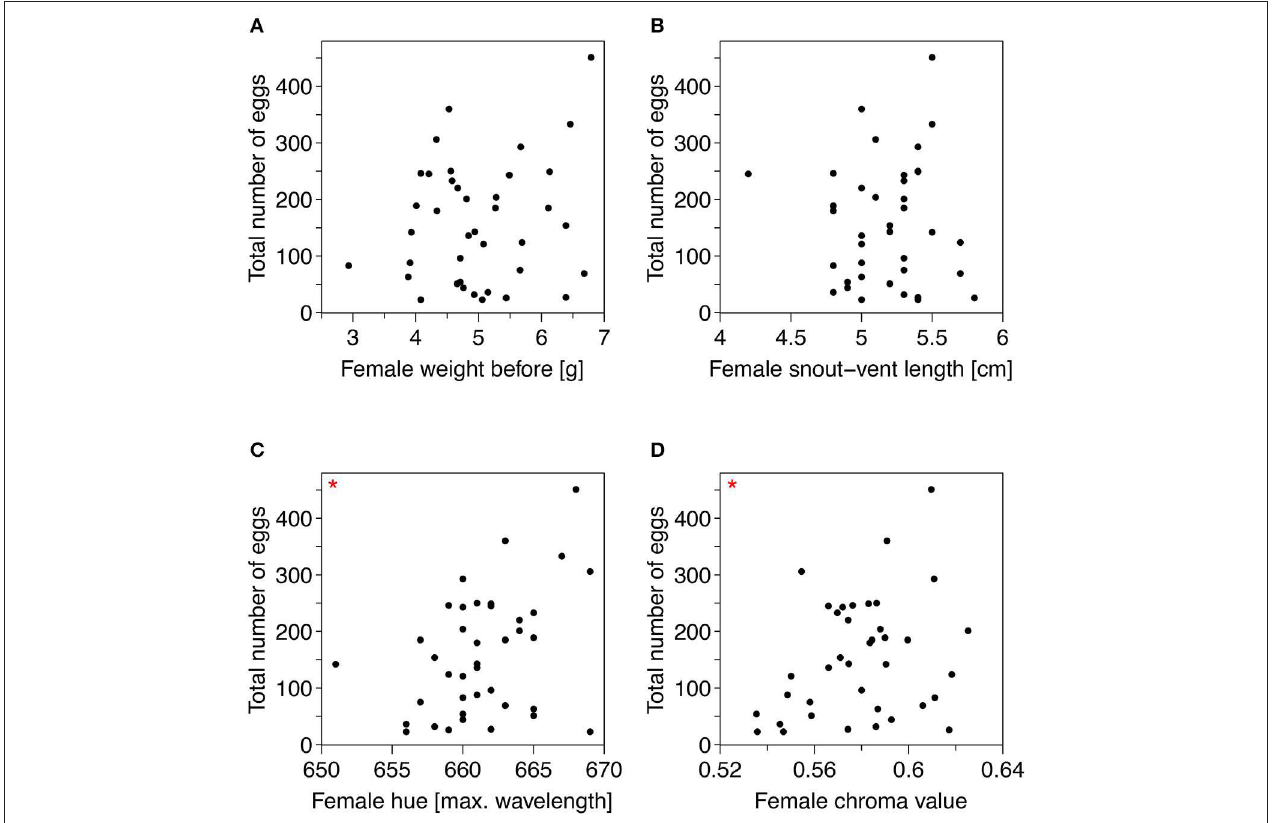
FIGURE 2 | Scatterplots illustrating the relationships between number of laid eggs and (A) female weight before the experiment started, (B) female snout-vent length (SVL), (C) female belly hue, and (D) female belly chroma. The red asterisks indicate significant correlations ( p < 0.05). N = 39.